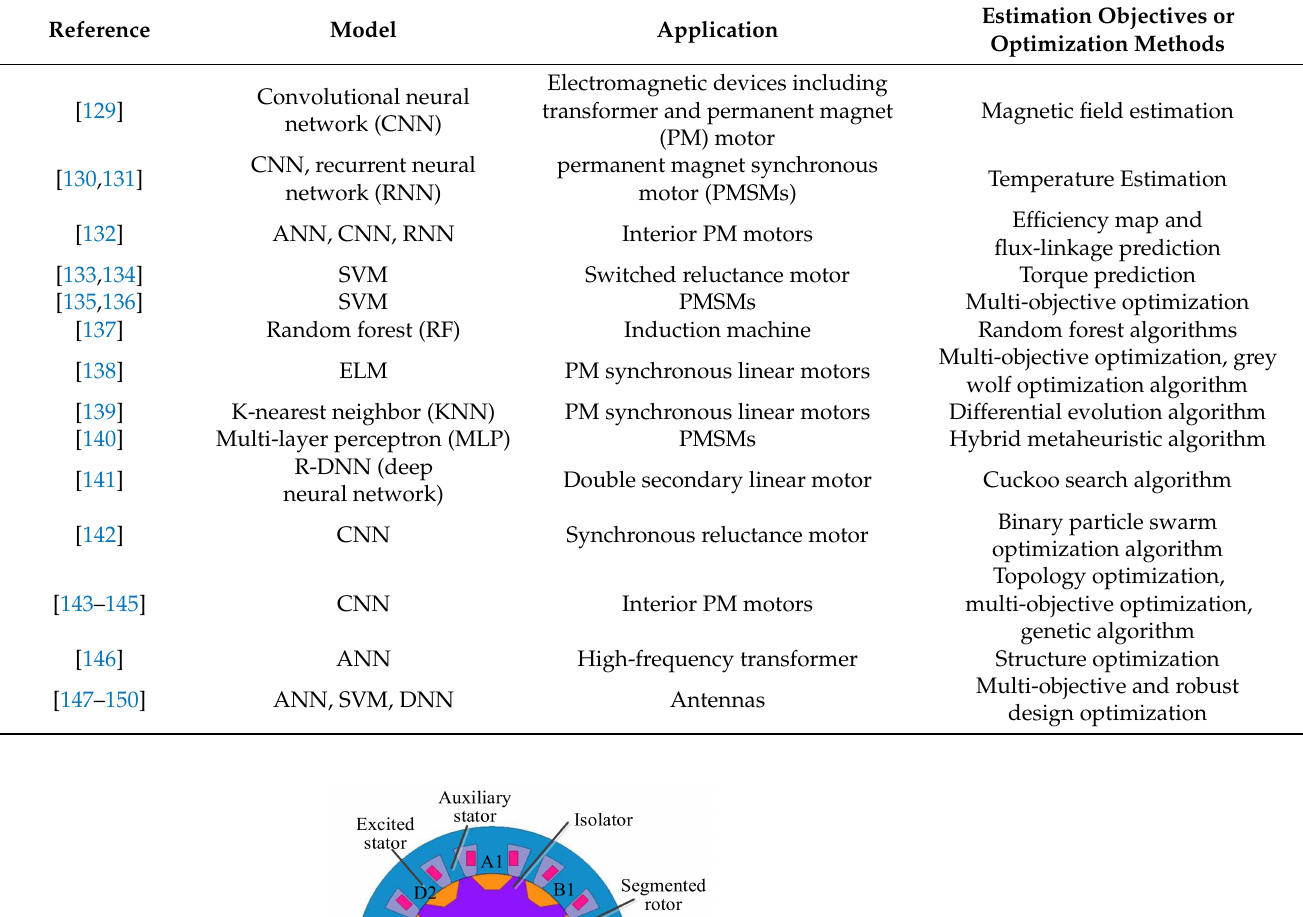
Table 2. Selective bibliography focusing on electromagnetic device design optimization based on different machine learning methods.